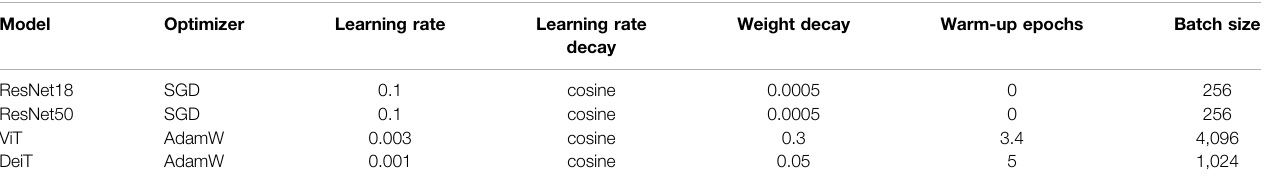
TABLE 5 | Training strategy and hyper-parameter settings.